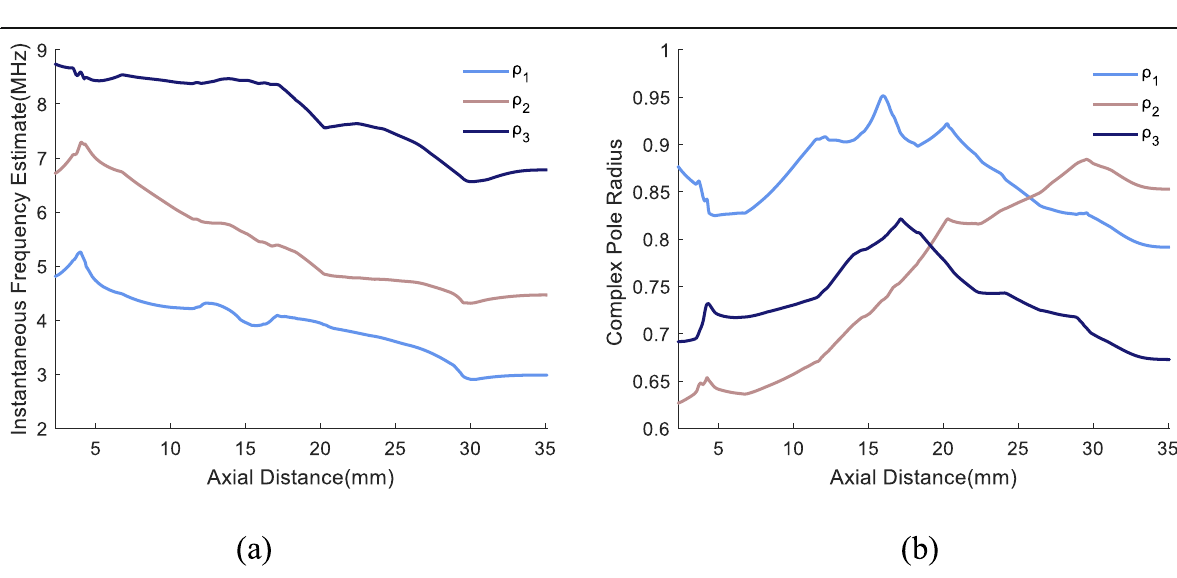
Fig. 10 a Time evolution of the instantaneous frequency estimates that correspond to the three identified complex poles. b Time evolution of the radius of each complex